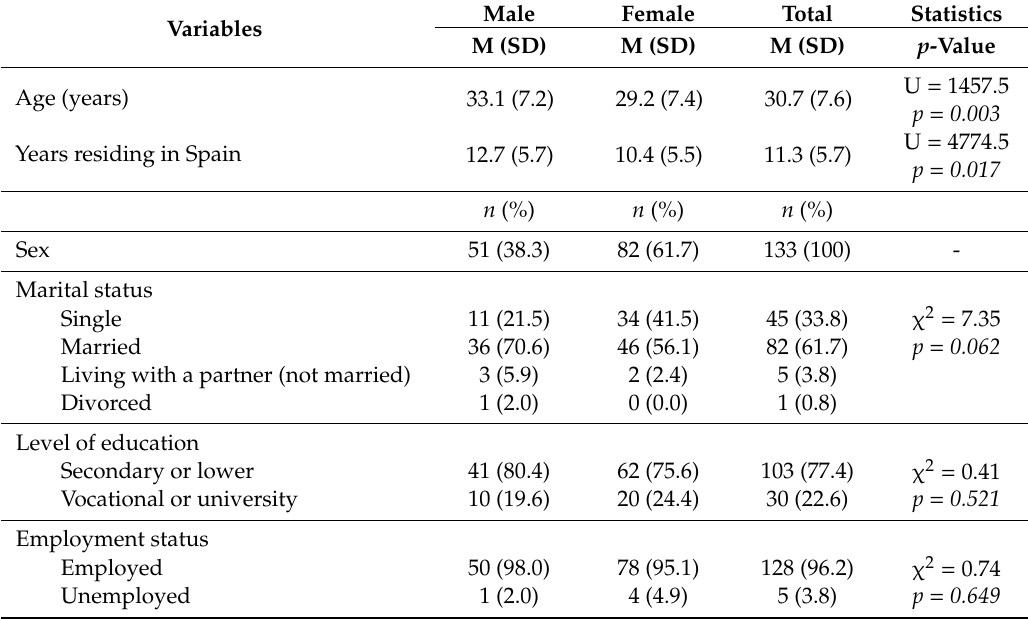
Table 1. Sample characteristics